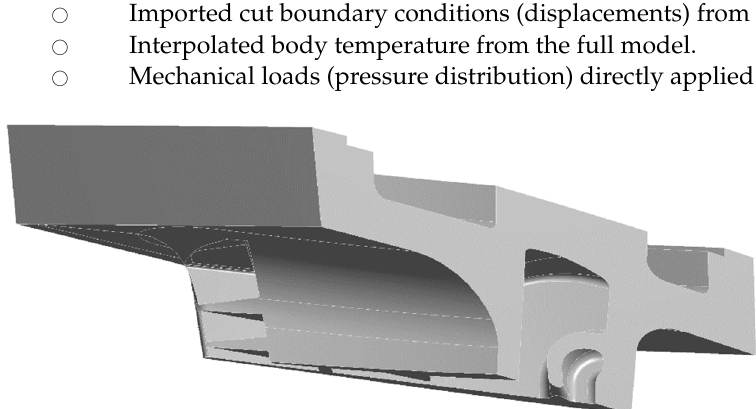
Figure 5. Sub-model of the vane around the platform external trailing edge (PETE) region.